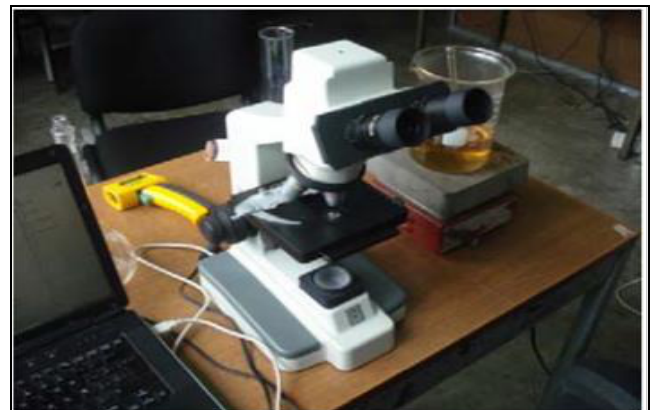
Figura 2: Microscopio National Instruments, DC5-163. Fuente: Los autores,